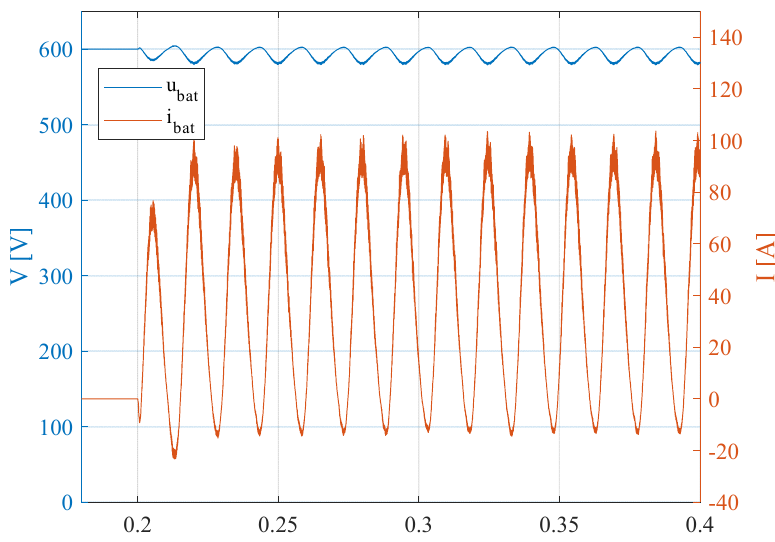
Figure 26. Time waveforms of battery voltage and current.